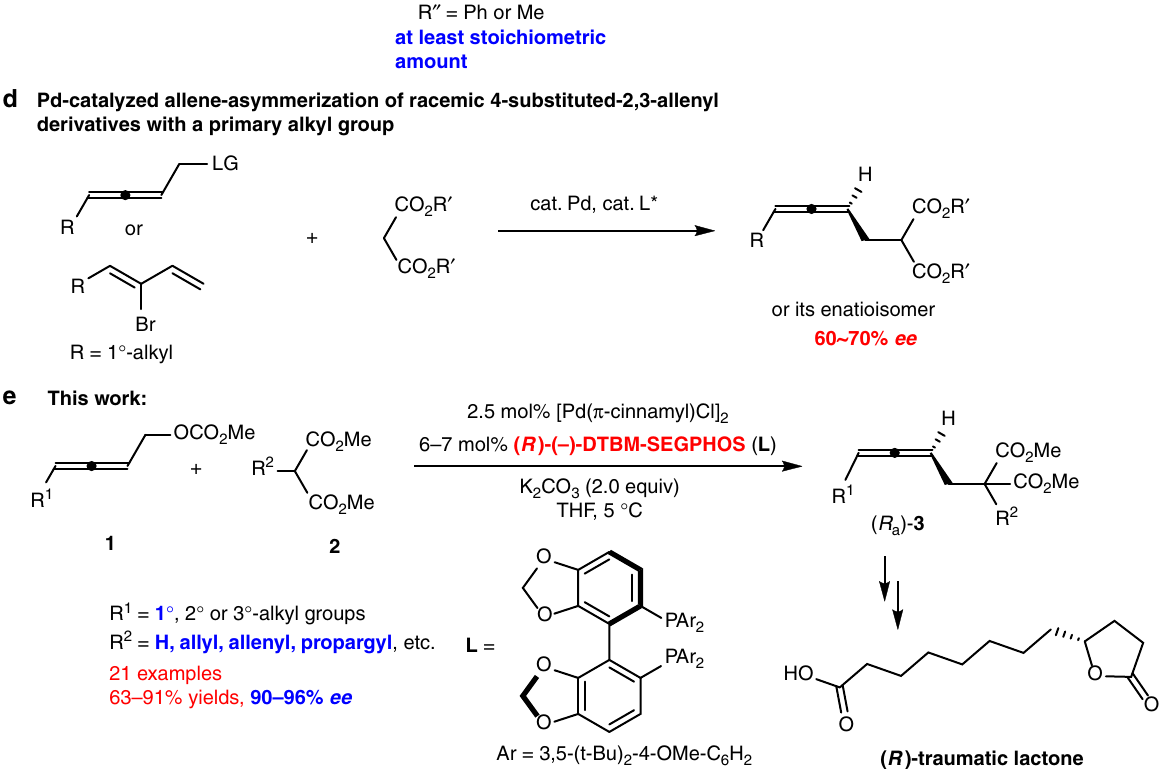
Fig. 2 Typical approaches to chiral 1,3-disubstituted allenes. a , b The current situation with such allene synthesis. c , d Reported strategies. e The approach developed in this